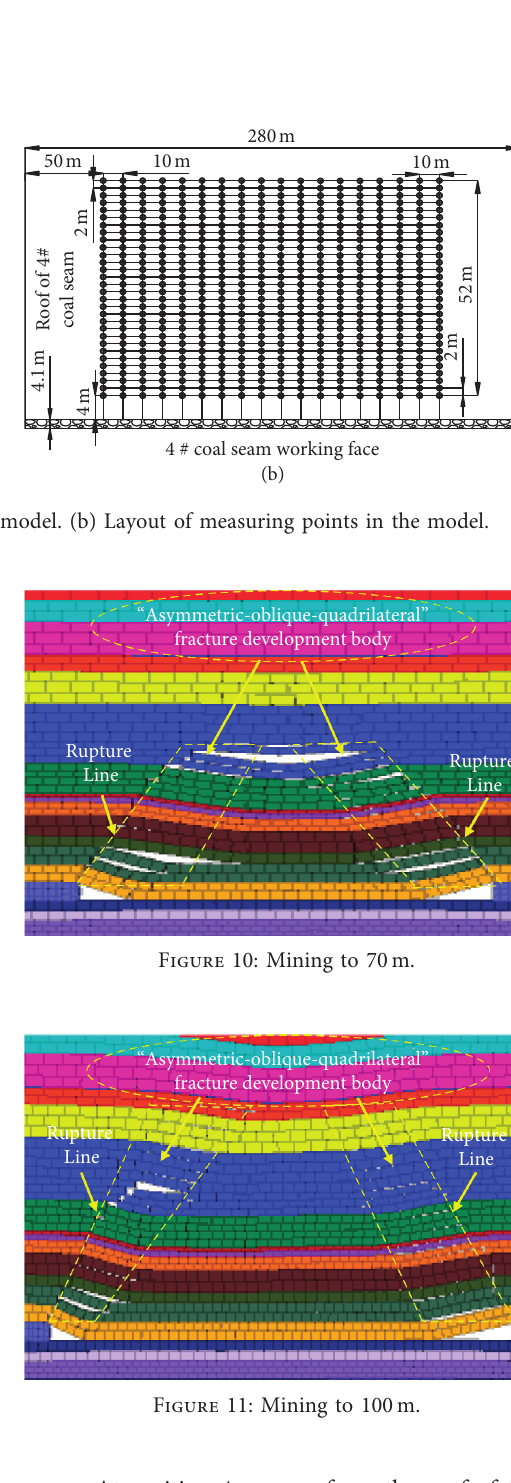
Figure 11: Mining to